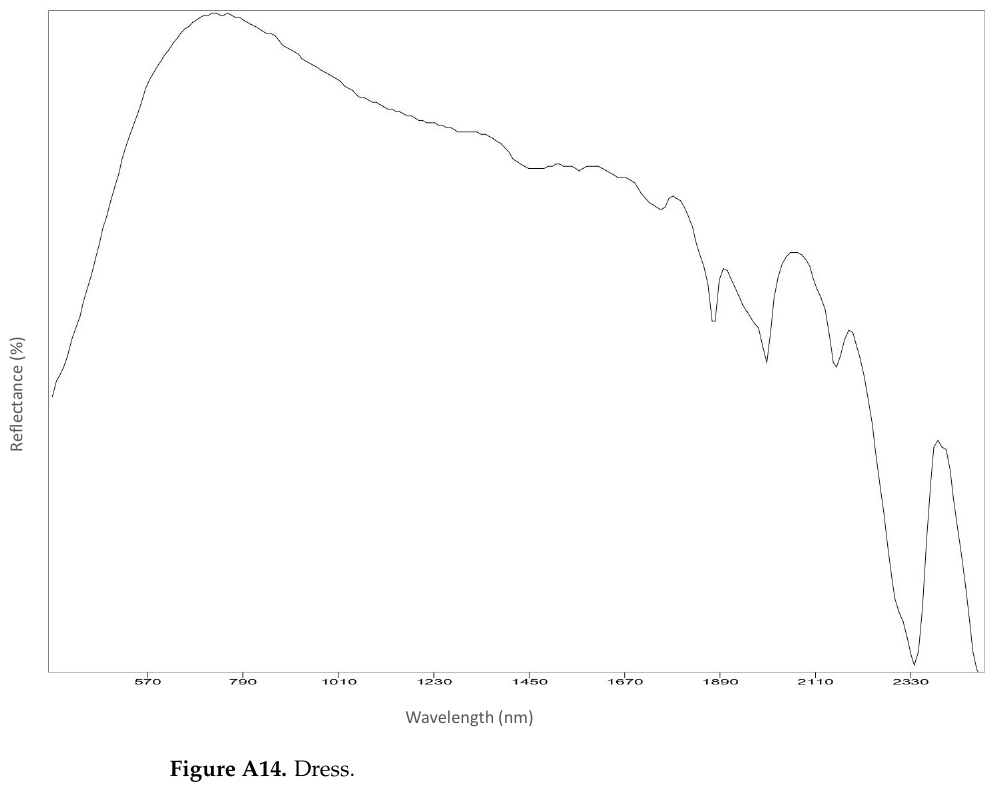
Figure A14. Dress. Figure A14. Dress.